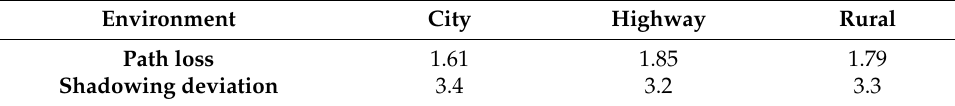
Table 3. Channel parameters [65].